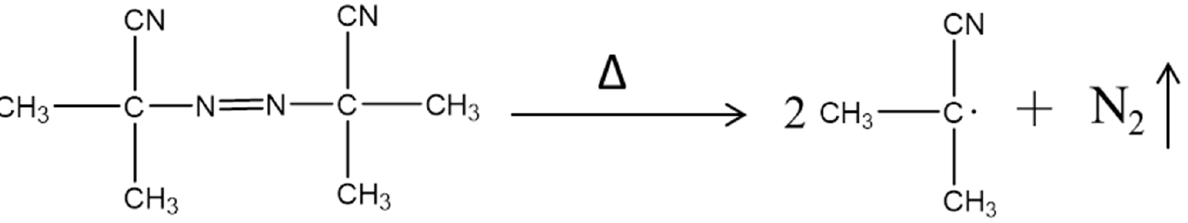
Figure 7. The decomposition of AIBN.